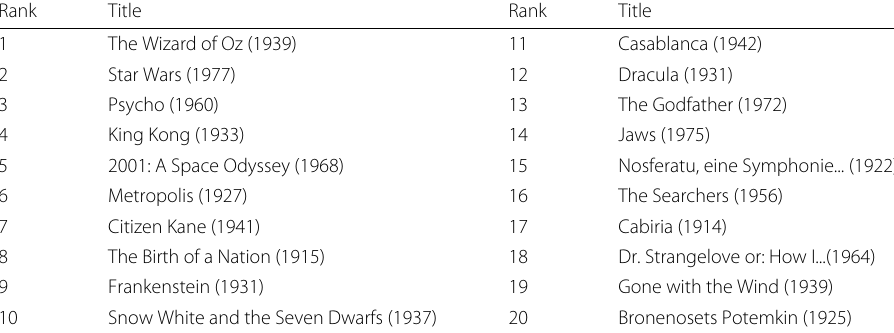
Table 2 Top 20 movies by influence centrality